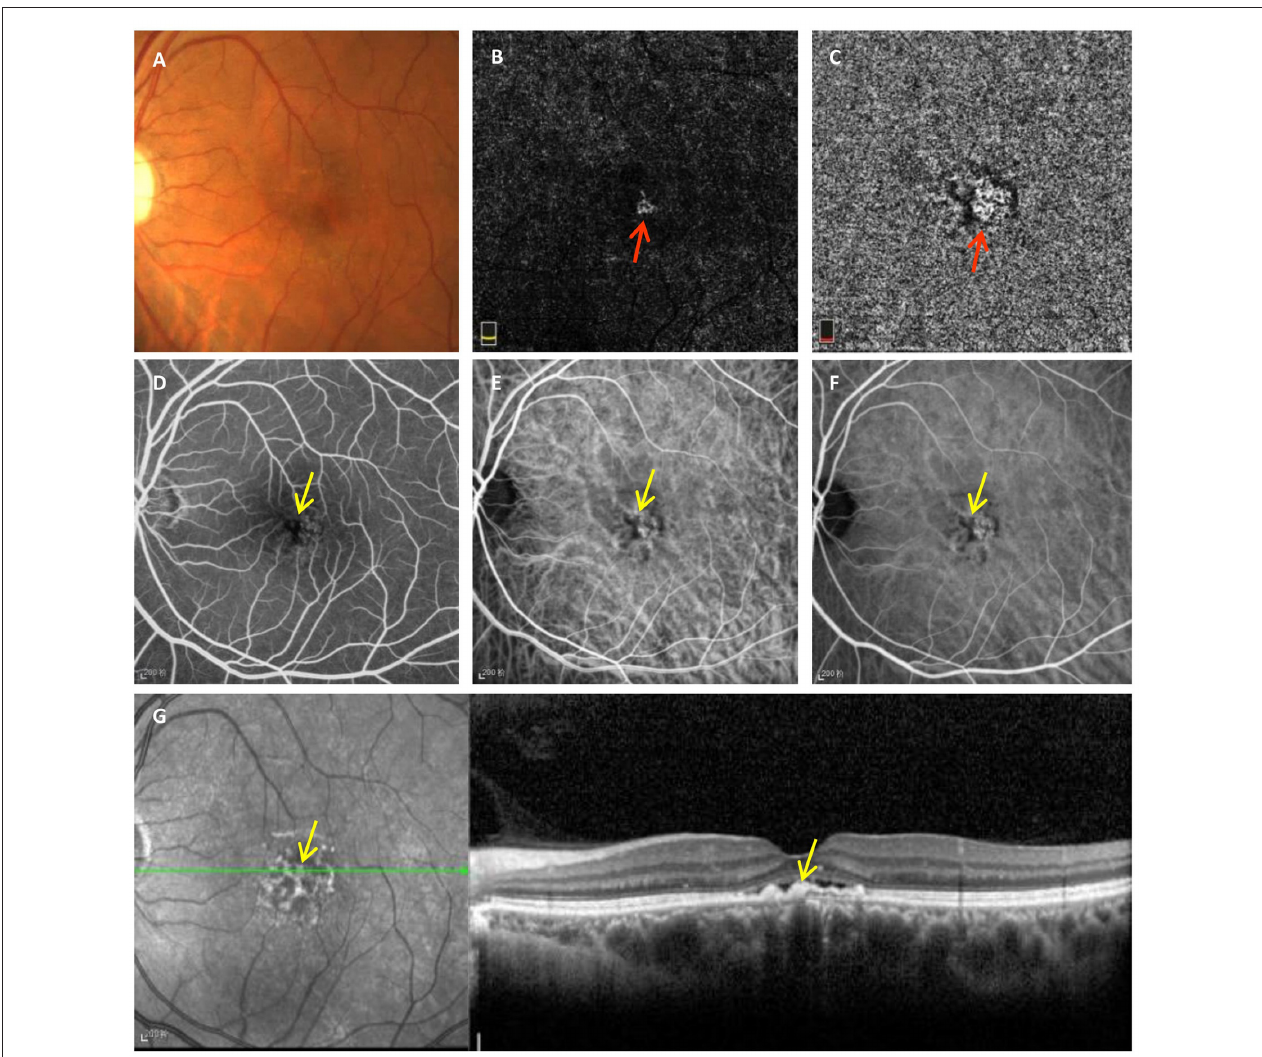
FIGURE 2 | Typical manifestations of RPE thickening on multimodal imaging observed in chronic CSC with vascularized FIPED. Fundus photography (A) showed faint dark pigmented spots in the foveal area. En face OCTA of the outer retina (B) and choriocapillaris (C) showed CNV signals (red arrow). Early-phase FFA (D) showed blocked fluorescence (yellow arrow) in the fovea. Early-phase (E) and mid-phase ICGA (F) showed blocked fluorescence (yellow arrow) and choroidal vasodilation on the fovea. Hyperreflective dots on IR (G) and areas of RPE aggregations on OCT (yellow arrow) corresponded to regions with blocked fluorescence on FFA and ICGA, respectively. RPE, retinal pigment epithelium; CSC, central serous chorioretinopathy; FIPED, flat irregular pigment epithelial detachment; OCTA, optical coherence tomography angiography; CNV, choroidal neovascularization; FFA, fundus fluorescein angiography; ICGA, indocyanine green angiography; IR, infrared reflectance.